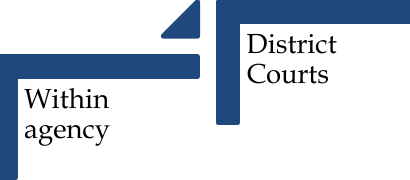
Figure 9: Levels of RTI Appeals in the United States